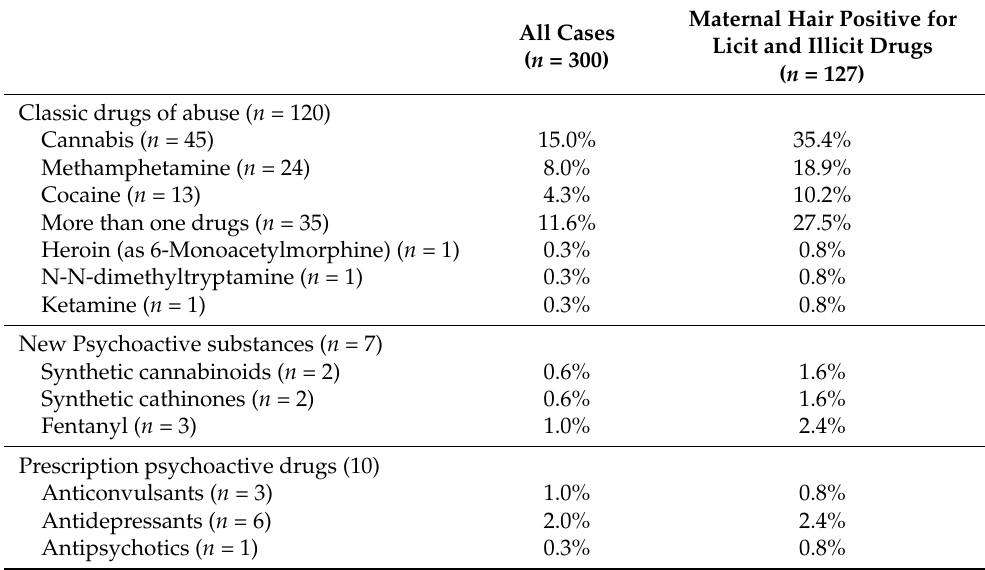
Table 2. Percentage of licit and illicit substances in hair samples from all the enrolled women ( n = 300) and in the 127 women whose hair was positive for any psychoactive drug.